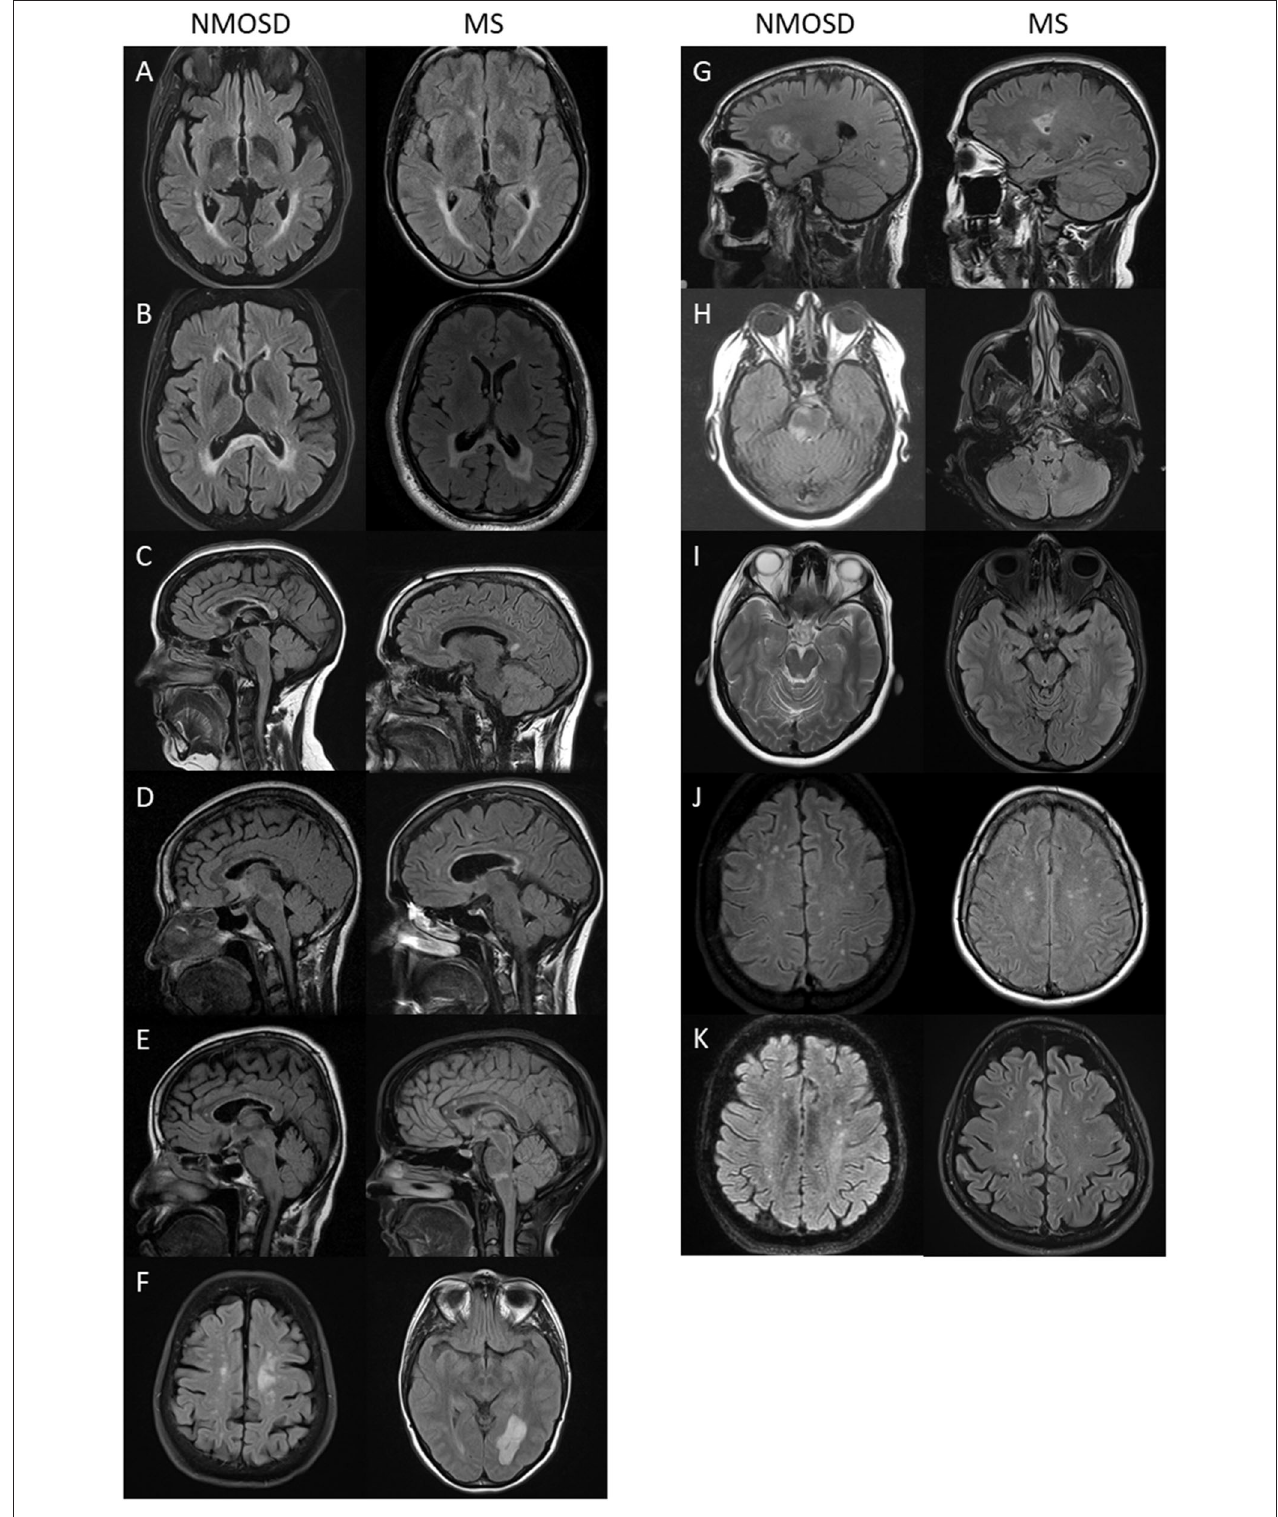
FIGURE 8 | Lesions previously described in NMOSD that were seen with equal frequency in NMOSD (left panel) and multiple sclerosis (right panel): (A) linear periventricular periependymal T2 lesions; (B) “bridging” T2 lesion of the splenium; (C) heterogenous T2 lesion of the corpus callosum; (D) rounded corpus callosum lesion; (E) pencil-like corpus callosum lesion; (F) tumefactive white matter lesion; (G) cystic brain lesion; (H) periependymal brainstem T2 lesion; (I) cerebral peduncle lesion (here seen bilaterally in multiple sclerosis); (J) punctate white matter lesions; and (K) patch white matter lesions.